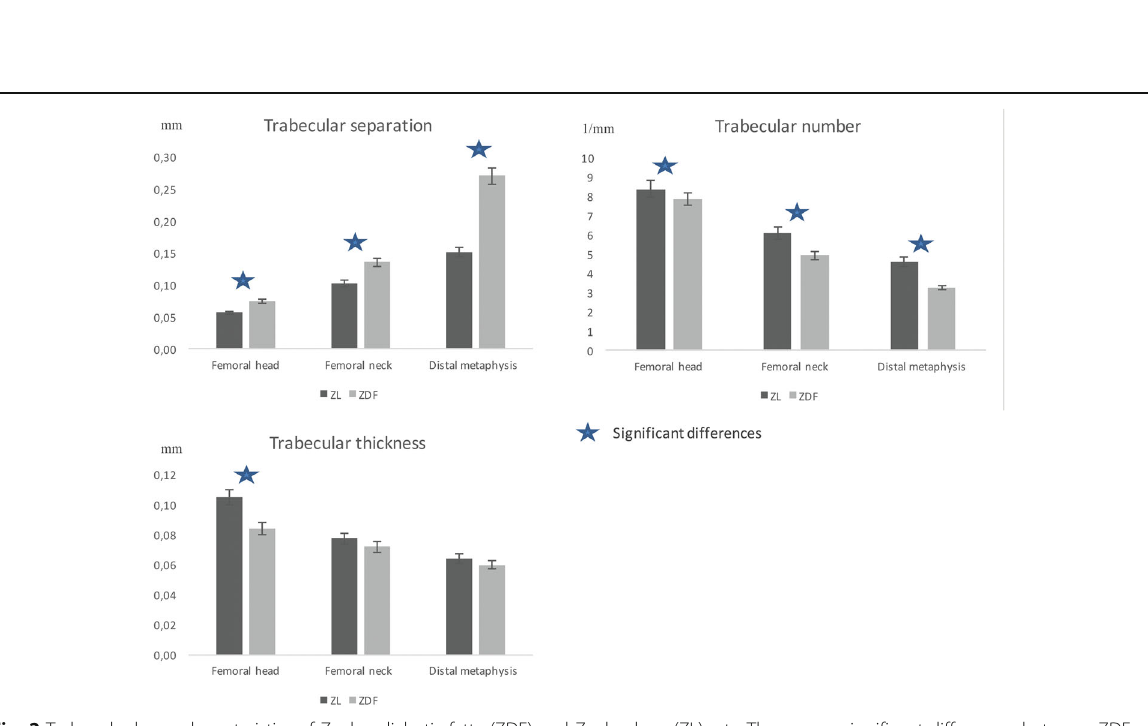
Fig. 2 Trabecular bone characteristics of Zucker diabetic fatty (ZDF) and Zucker lean (ZL) rats. There were significant differences between ZDF and ZL rats concerning the number and the separation of trabeculae in the head, neck, and distal metaphysis. Trabecular thickness was significantly different only in the